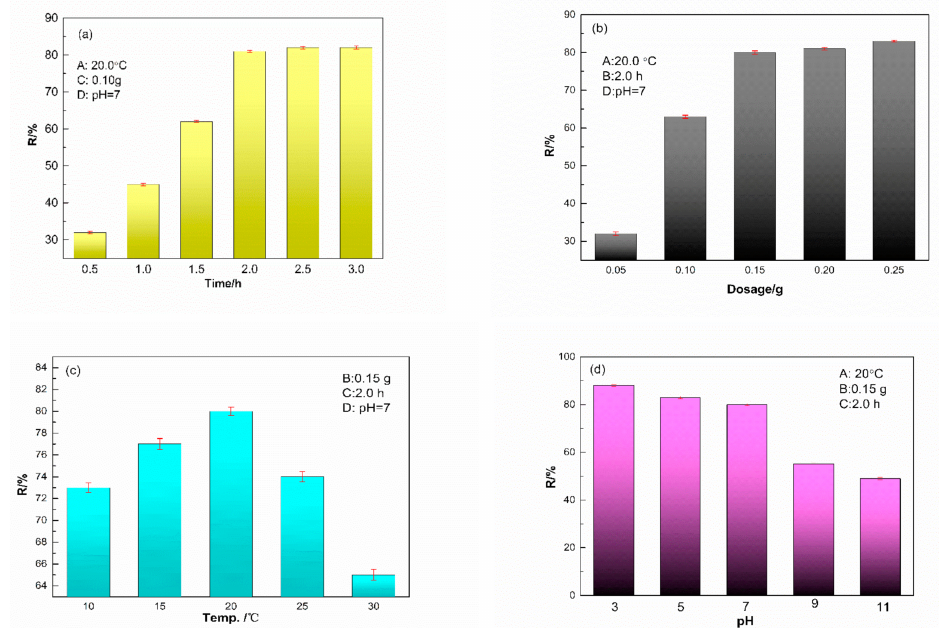
Figure 7. The results of single-factorial experiments. ( a ) contact time; ( b ) adsorbent dosage; ( c ) ad- sorption temperature; ( d ) solution